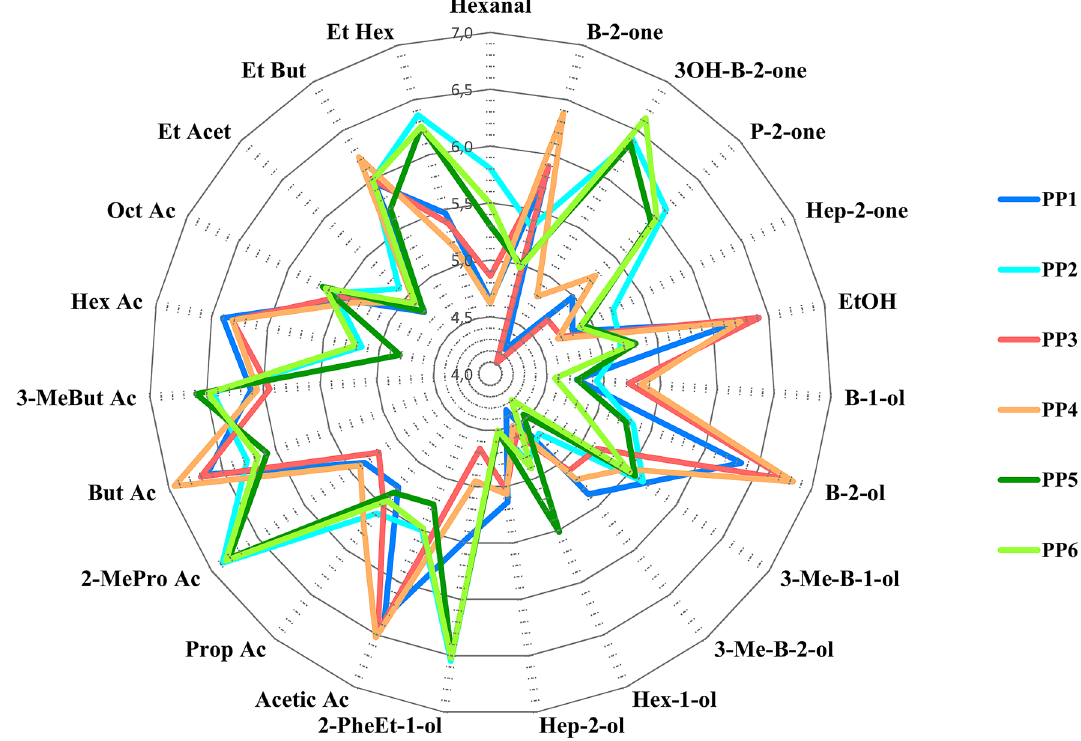
Figure 4. Radar plots showing the terpenoid profiles of HR cheese according to Pasture area-Producer. Abundance of terpenes is reported in arbitrary units as the logarithmic relative peak intensities of Quant ion